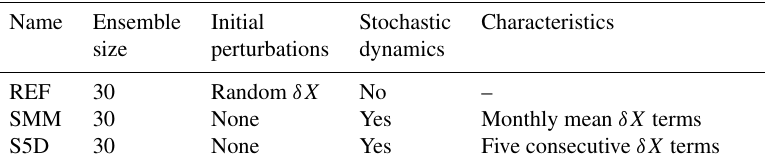
Table 1. Characteristics of the seasonal re-forecast experiments discussed in this paper. Name Ensemble Initial Stochastic Characteristics size perturbations